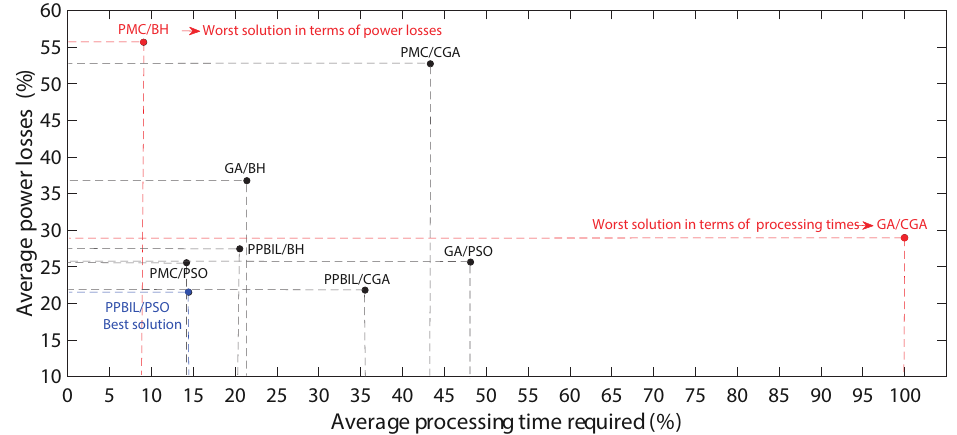
Figure 13. Impact of the hybrid methods in all test